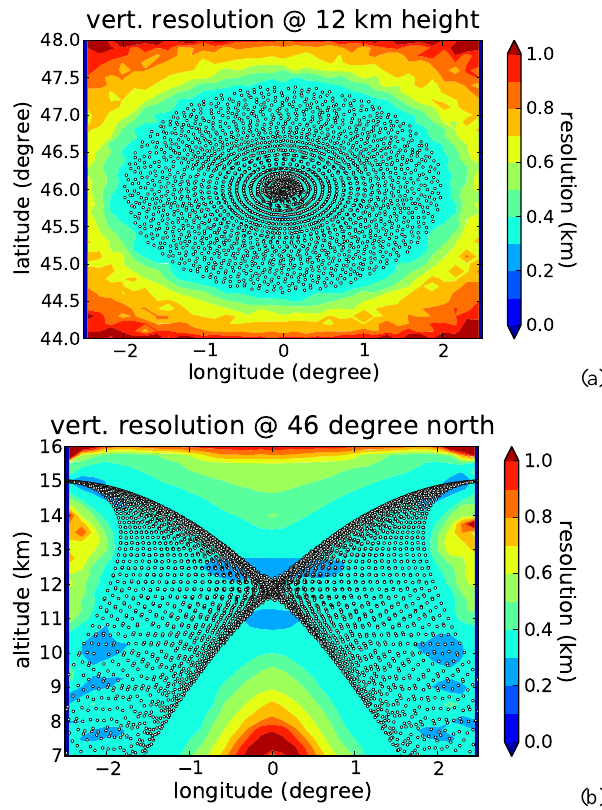
Fig. 6. The retrieval result of the baseline setup without added instrument noise. (a) Shows the retrieved ozone values at 12km height while (b) depicts the relative error in percent compared to the true values.